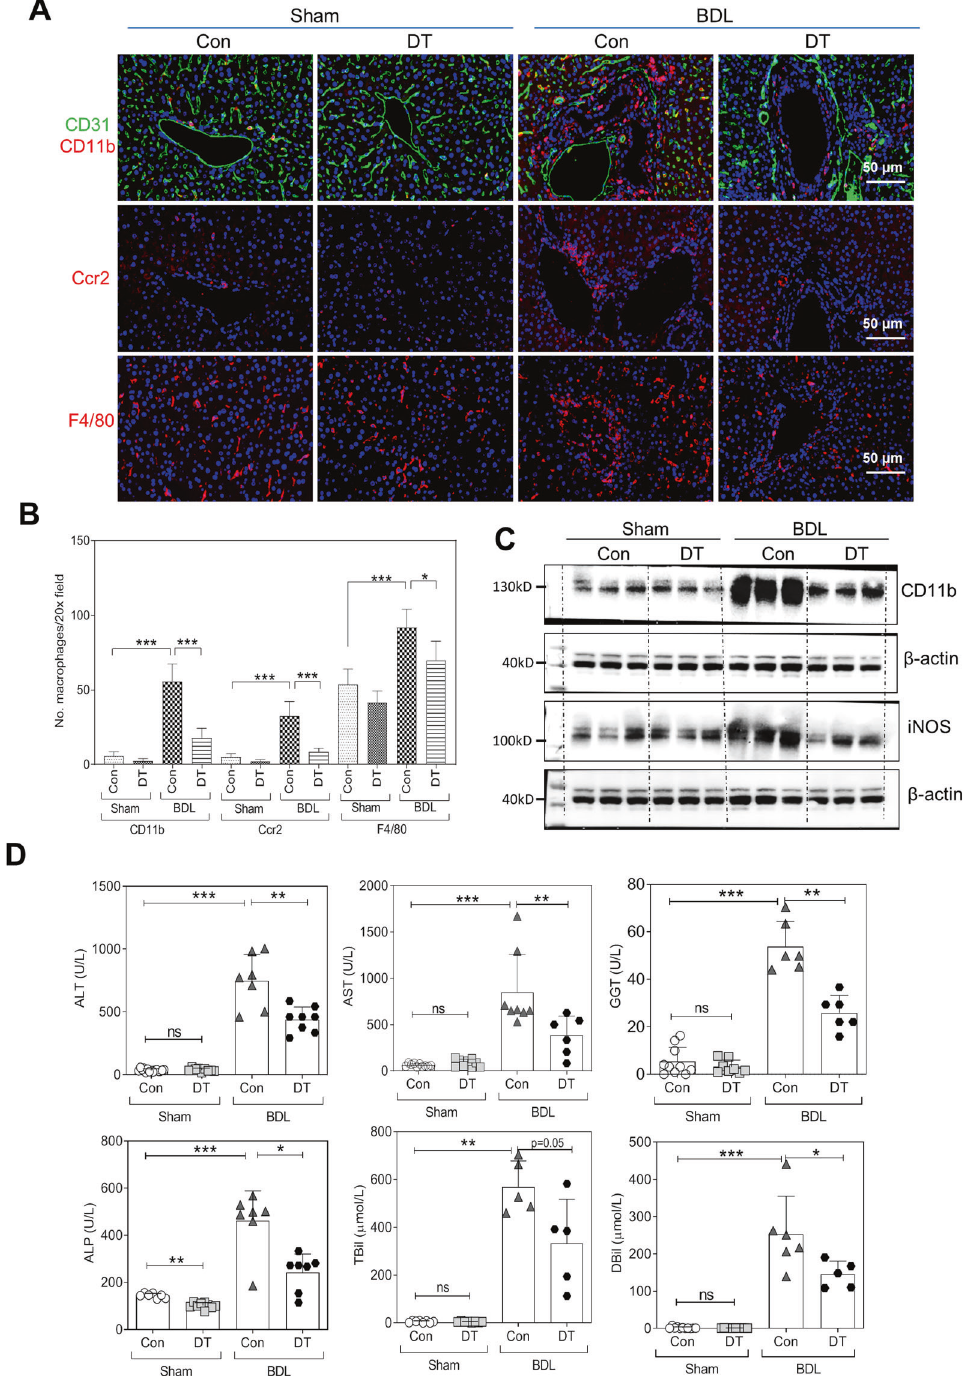
Fig. 2 Diphtheria toxin (DT) injection depleted macrophages in the cholestatic livers and ameliorates liver injury. A The mice were divided into groups of Sham, Sham + DT, BDL, and BDL + DT ( n = 5 – 8). Representative images of immuno fl uorescence (IF) staining for CD11b, Ccr2, F4/80, and CD31 in the livers of Sham, Sham + DT, BDL, and BDL + DT mice Scale bars: 50 μ m. B Quanti fi cation of Ccr2 + , F4/80 + , and CD11b + cells in panel A by ImageJ. C Western blotting analysis for CD11b and iNOS in Sham, Sham + DT, BDL, and BDL + DT mice. Representative images of three duplicate samples of the immune blottings are shown. D The levels of alanine aminotransferase (ALT), aspartate aminotransferase (AST), alkaline phosphatase (ALP), γ -glutamyl transferas (GGT), total bilirubin (TBil), and direct bilirubin (DBil) in serum ( n = 5 – 13, each group). Data were expressed as mean ± SD. * P < 0.05; ** P < 0.01; *** P <